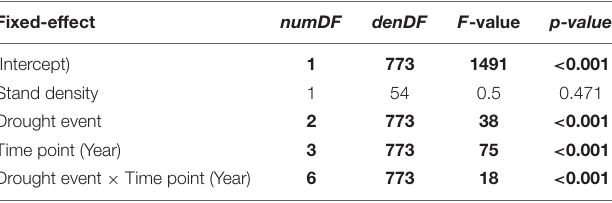
TABLE 2 | ANOVA table for the mixed-effects model of BAI, where numDF = numerator degrees of freedom, denDF = denominator degrees of freedom, interactions are denoted by a × and significant effects ( p < 0.05 ) are highlighted in